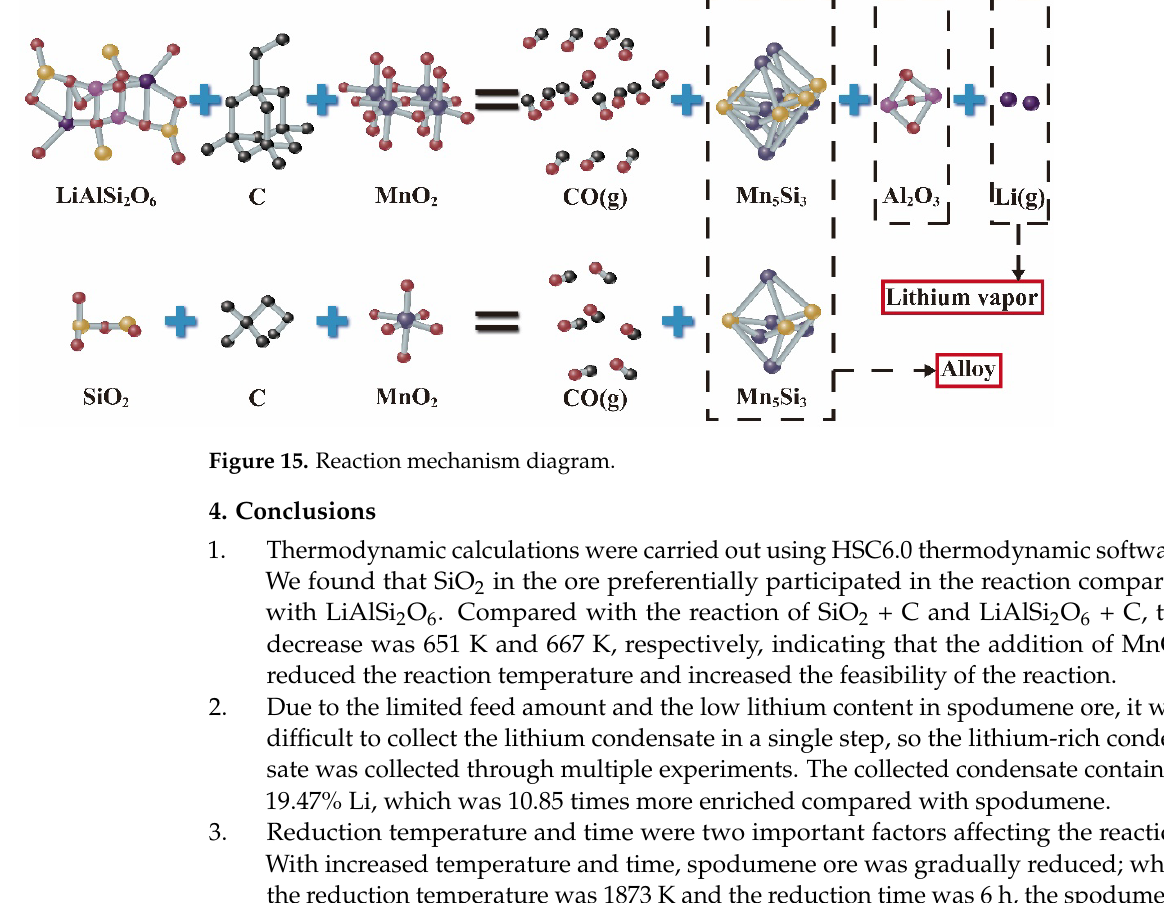
element distribution; ( h ) Si element distribution.